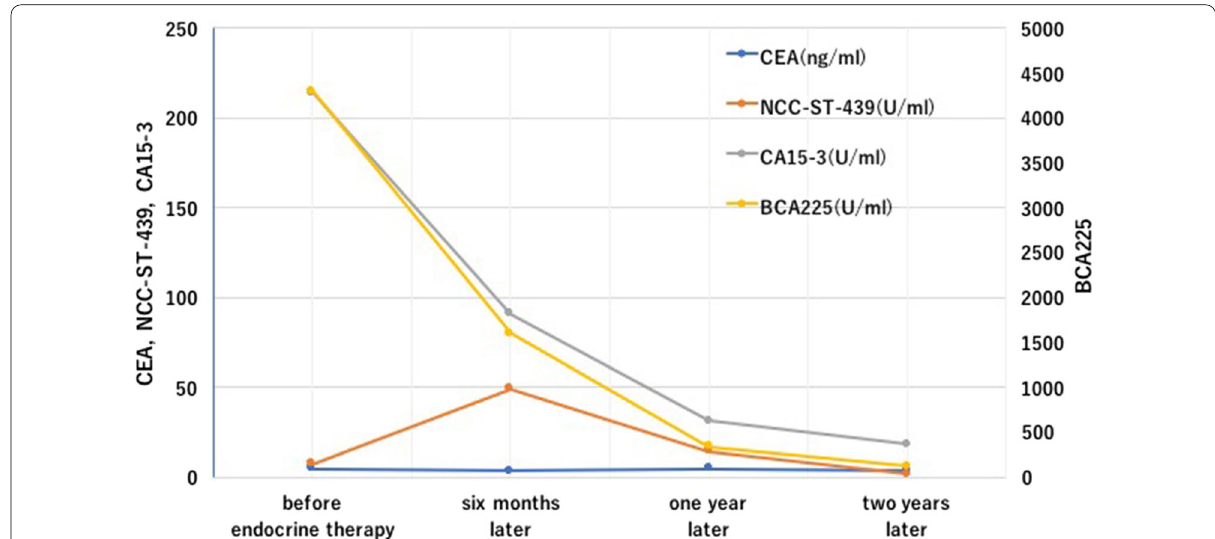
Fig. 7 Variations in the tumor marker values. No abnormal CEA values were obtained. CA15-3 and BCA225 values gradually declined from the time of recurrence, and returned to normal levels 2 years later. NCC-ST-439 values gradually increased up to 49 U/ml 6 months after relapse, and gradually decreased thereafter, reaching normal levels 2 years